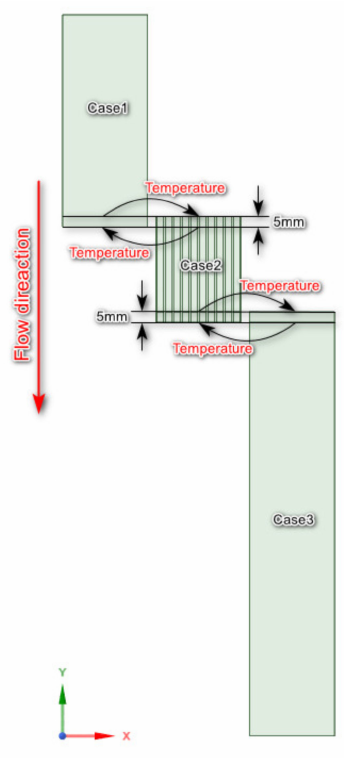
Figure 4. Schematic diagram of data